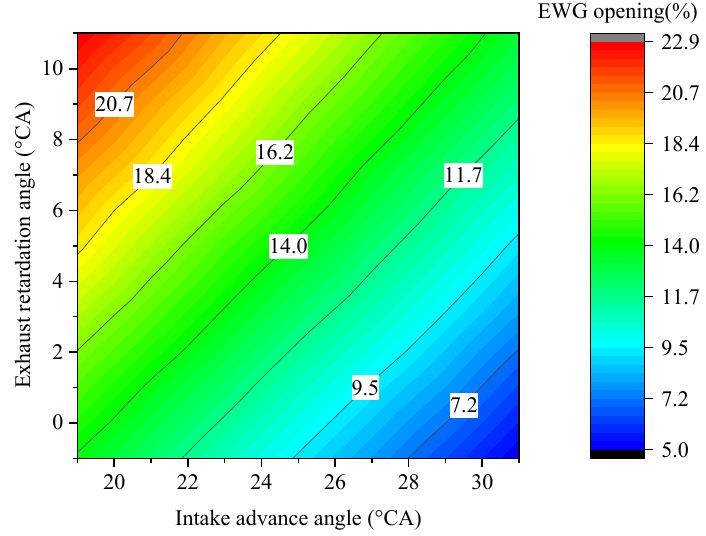
Figure 23. EWG opening versus the combined change of intake advance angle and exhaust retardation angle (point of operation: n = 3000 rpm, BMEP = 10 bar, CA50 = 8 °CA, throttle opening = 100%).